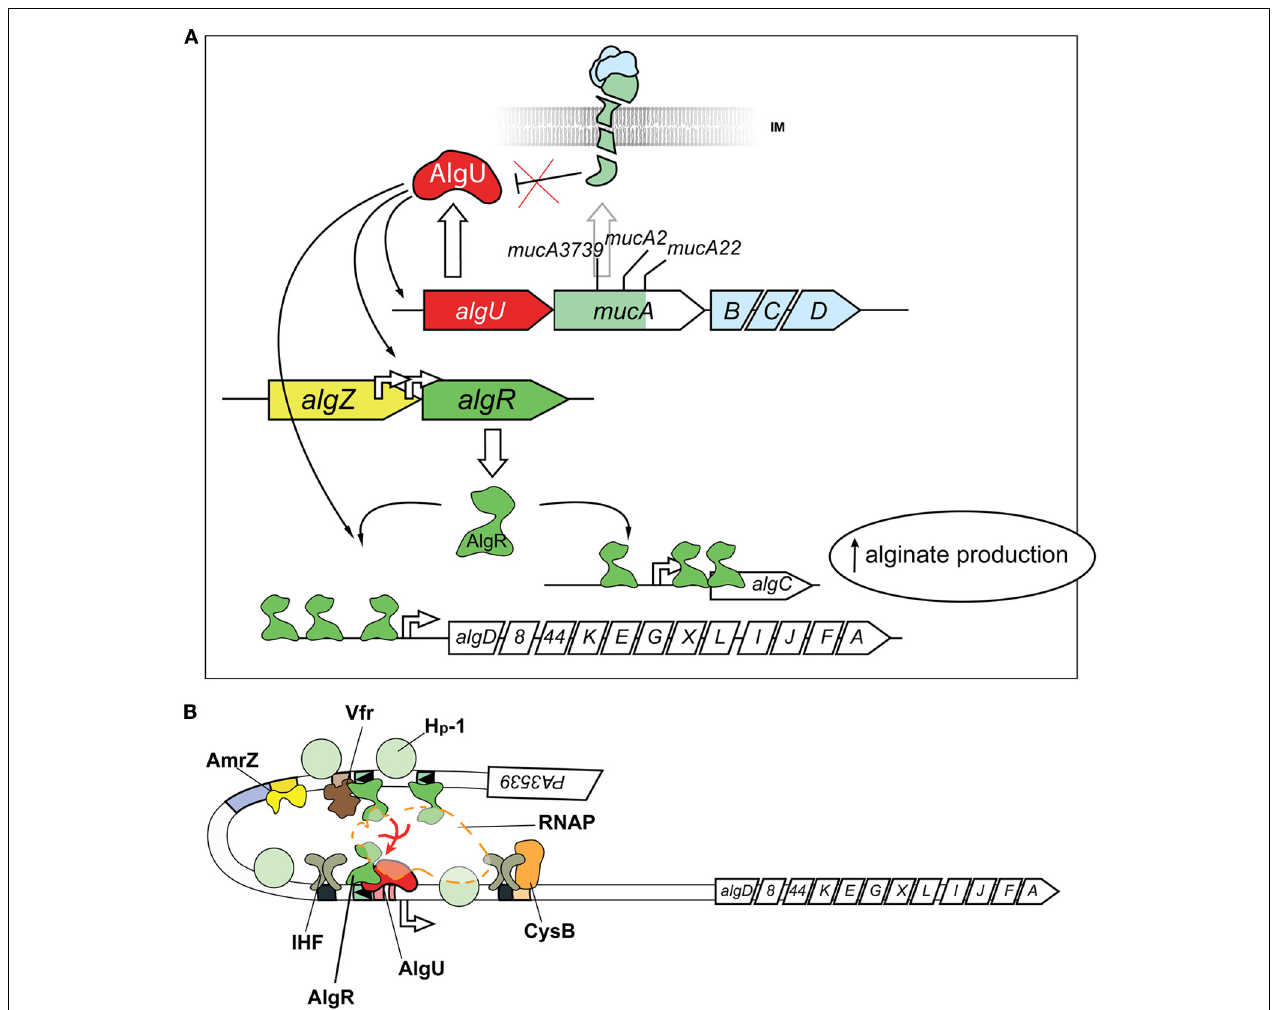
FIGURE 2 | Post-Translational and Transcriptional controls for alginate production. (A) Post-translational activation of the alternative sigma factor AlgU (AlgT) is required for alginate production. Release of AlgU (AlgT) by MucA (depicted as a broken green transmembrane comma) through mutation ( mucA3739, mucA2, mucA22 ) or degradation by proteases (see text) activates expression of itself, algR, and algD . AlgU (AlgT) and AlgR coordinate activation of the algD promoter along with other transcriptional activators (see B ). Gene names are labeled within arrowed boxes, and pointed end of boxes indicate open coding direction. (B) Transcriptional model for algD promoter activation. At least seven different transcriptional